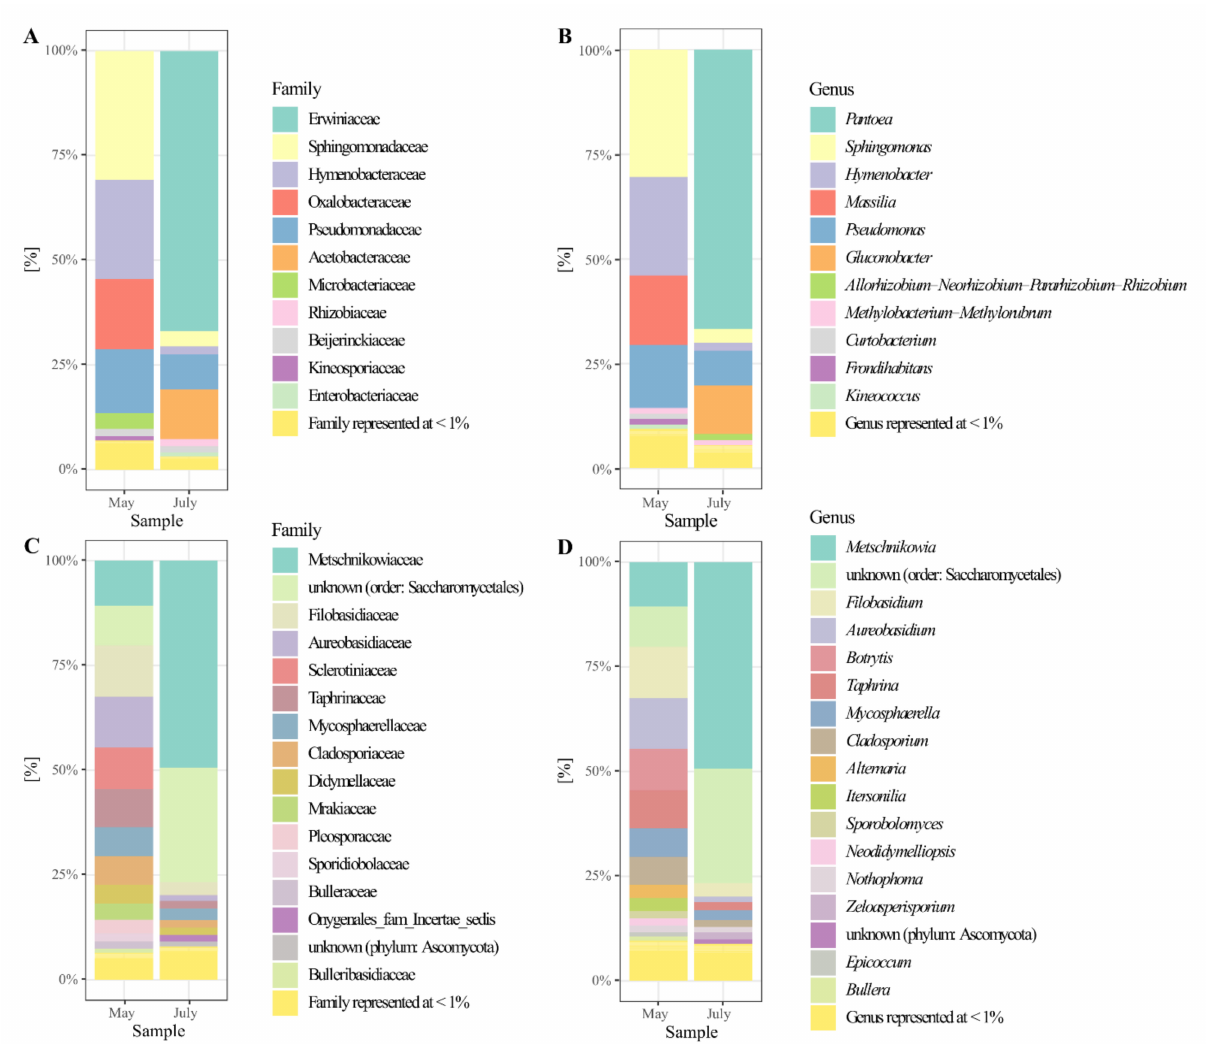
Figure 3. Relative abundance (RA) of bacterial and fungal families ( A , C ) and genera ( B , D ) associated with the ‘Williams’ pear variety at two phenological stages (May and July). Identified taxa above 1% of the total RA are